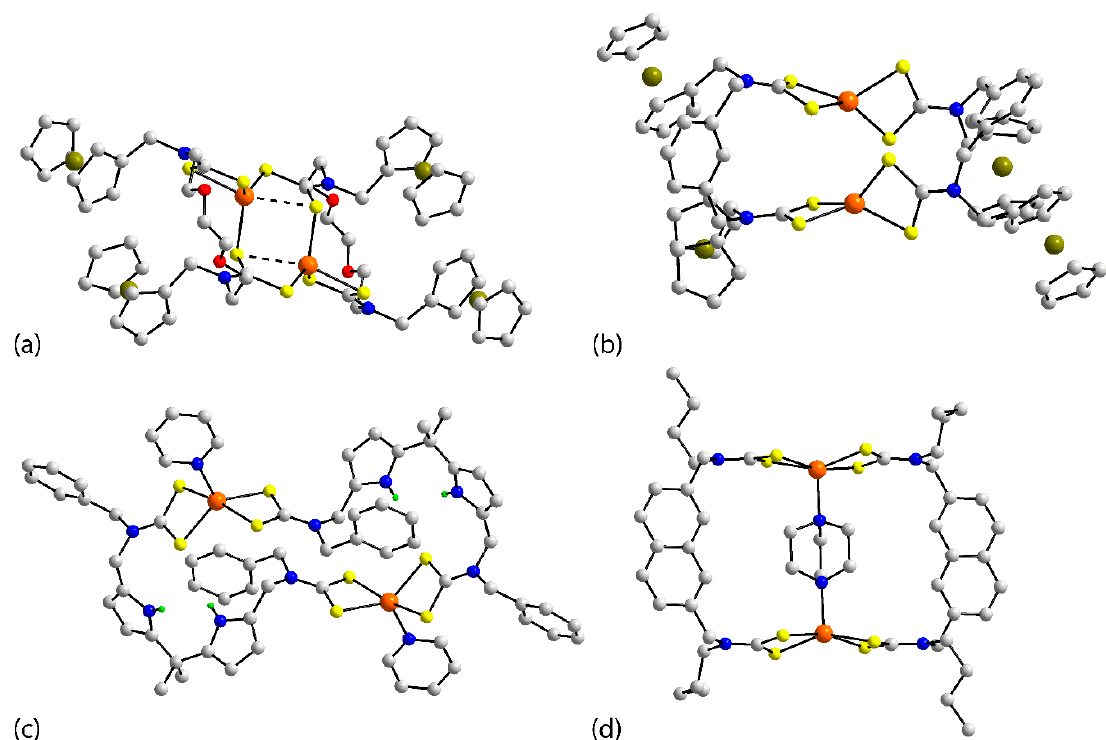
Figure 11. Molecular structures of ( a ) Zn 2 (L 16 ) 2 in the crystal of 39 (dashed lines indicate transannular Zn … S interactions), ( b ) Zn 2 (L 12 ) 2 in 40 , ( c ) Zn 2 (L 5 ) 2 (pyridine) 2 in 41 and ( d ) Zn 2 (L 9 ) 2 (N(CH 2 CH 2 ) 3 N) in 42 . Additional colour code: green, for acidic hydrogen atoms.